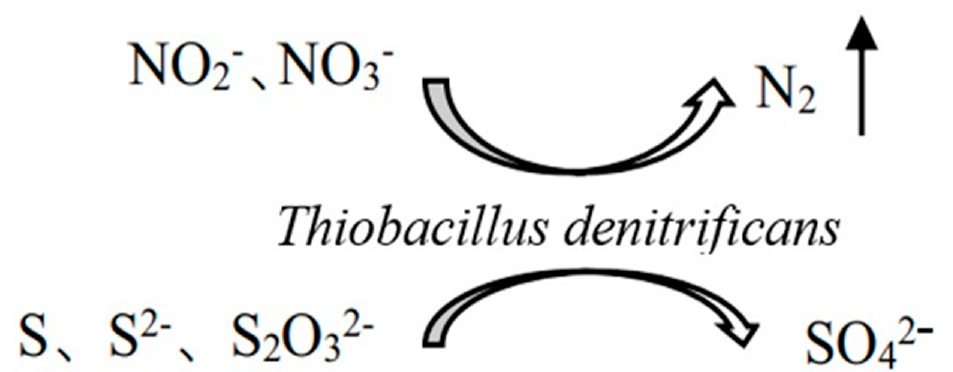
Figure 1. Sulfur autotrophic denitrification process.